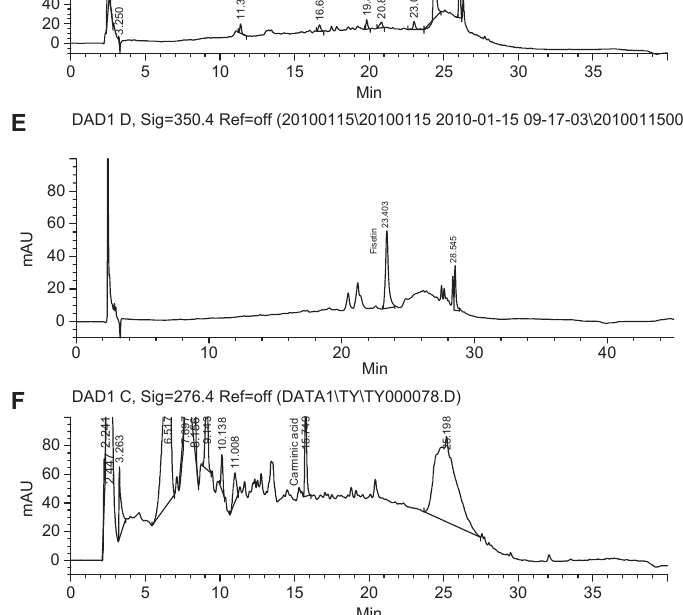
Figure 1 Chromatograms of samples extracted from art objects. Quercus infectoria or Quercus ithaburensis was used for black, green and beige colours and mordanting (HPLC profi le at 255 nm, inventory numbers: 13/1515, 13/1008) (A); Isatis tinctoria L. or Indigofera tinctoria L. were used for green, blue and light blue samples (HPLC profi le at 276 nm, inventory numbers: 13/1515, 13/1008, 13/1507, 13/1671, 13/1748 and 13/148) (B); Reseda luteola L. was used for yellow and green samples (inventory numbers: 13/1008, 13/1748 and 13/148, 13/1561, 13/456, 13/1678, 13/148), HPLC chromatogram collected at 350 nm for (C and D); samples dyed with Cotinus coggygria Scop. (inventory no. 13/1748 for sample of yellow silver klapdan) (E); samples dyed with Dactylopius coccus Costa (inventory no. 1561 for green sample)